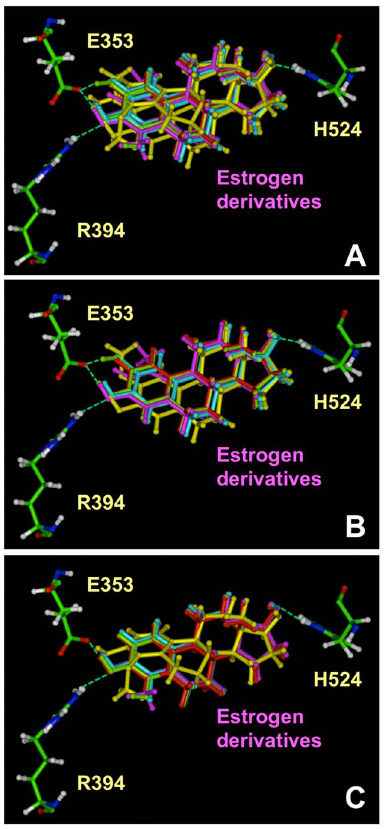
Figure 3. Overlay of docked and crystal structures of ER a LBD in complex with DES or E 2 . A . Superimposed structures of docking result and the crystal structure of ER a LBD in complex with DES. The known crystal structure of ER a LBD in complex with DES (PDB code: 3ERD) was colored in yellow with DES colored in green. The docked DES was colored in orange and ER a LBD was colored in magenta. B . Superimposed structures of docking result and the crystal structure of ER a LBD in complex with E 2 . The known crystal structure of ER a LBD in complex with E 2 (PDB code: 3ERE) was colored in yellow with E 2 colored in green. The docked E 2 was colored in orange and ER a LBD was colored in magenta. The green dashes indicated the hydrogen bonds formed. All the structures were shown in ball and stick. The atoms involved with hydrogen bond formation were colored according to the atom type, i.e. white for hydrogen, red for oxygen and blue for nitrogen. Hydrogen atoms in other amino acids were not shown.